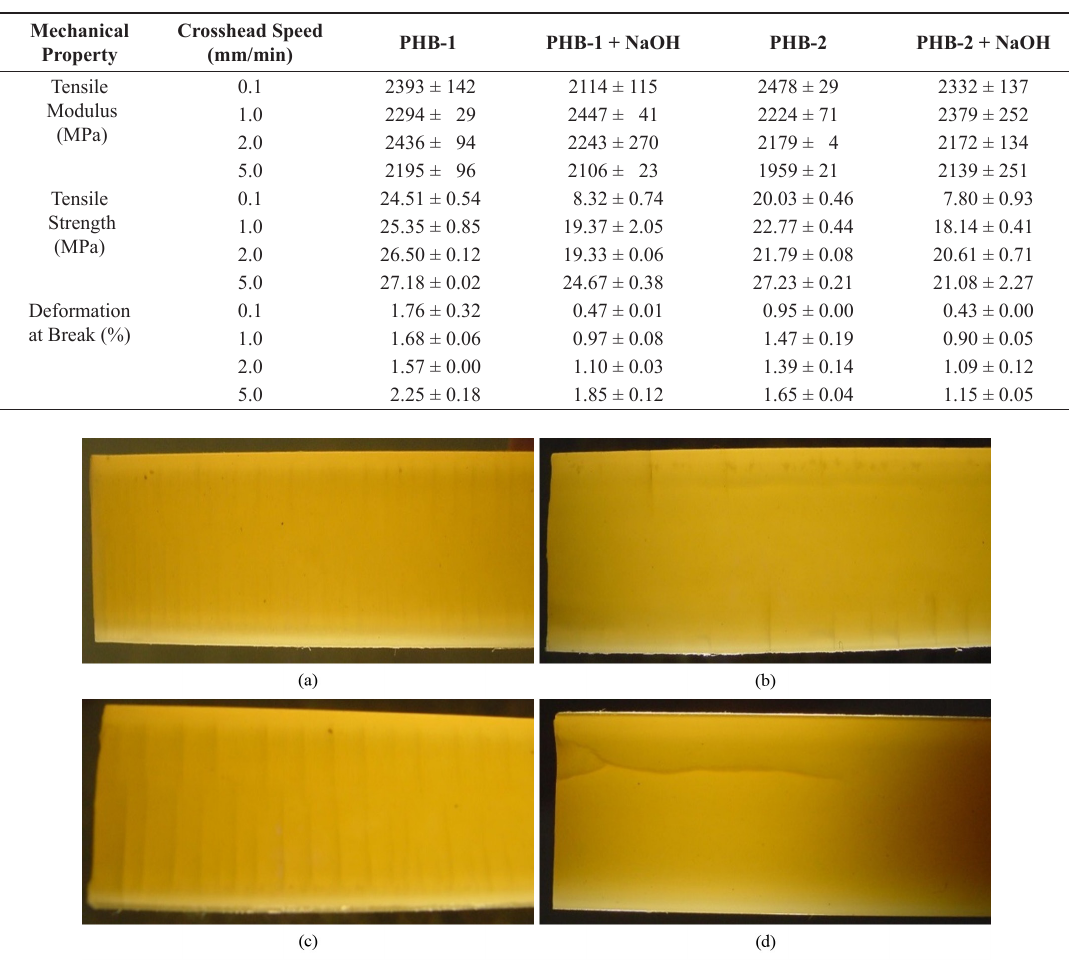
Figure 4. Macrophotographic images of the surface of PHB-1 samples after tensile testing: (a) unexposed to NaOH at 2 mm/min, (b) exposed to NaOH at 2 mm/min, (c) unexposed to NaOH at 0.1 mm/min, (d) exposed to NaOH at 0.1 mm/min.